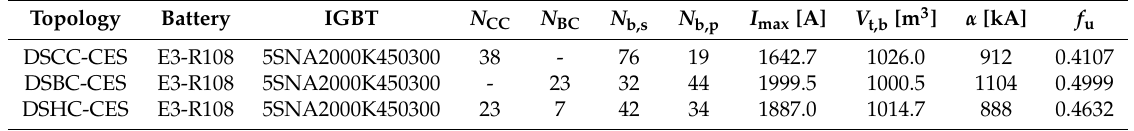
Table 5. Summary of the selected designs for CES